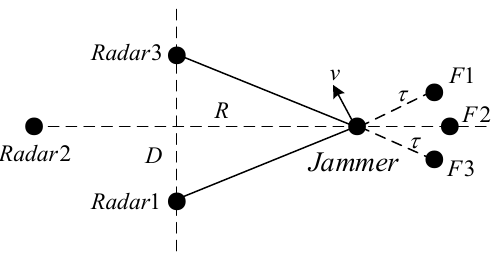
Figure 11. Distribution diagram of three radars. Table 5. Radar network parameters (three radars).